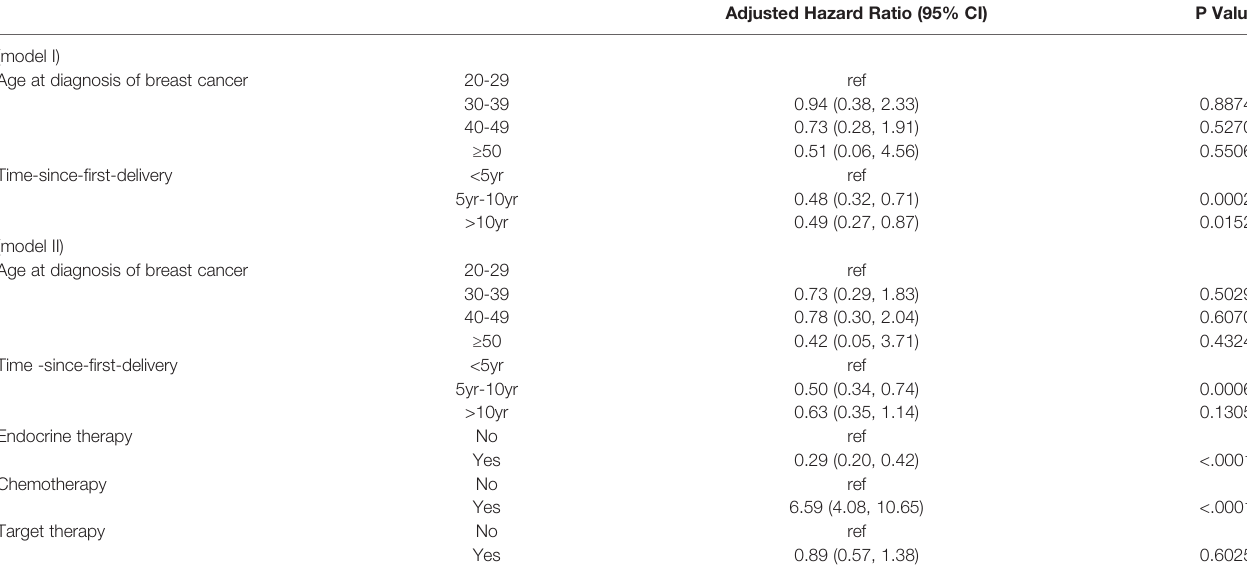
TABLE 5 | Multivariate analysis (model I) of survival (overall survival) for breast cancer patients in women who had fi rst delivery in 2007.